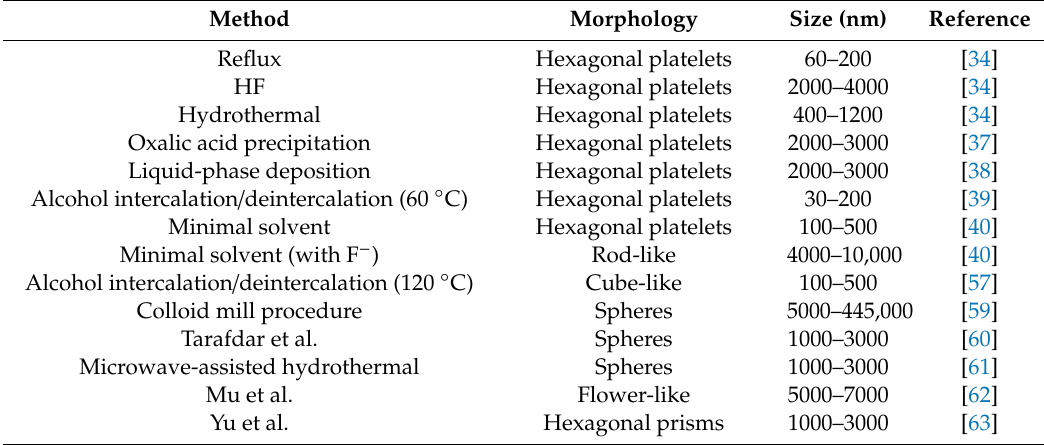
Table 1. Summarizing table on the di ff erent preparation methods of ZrP